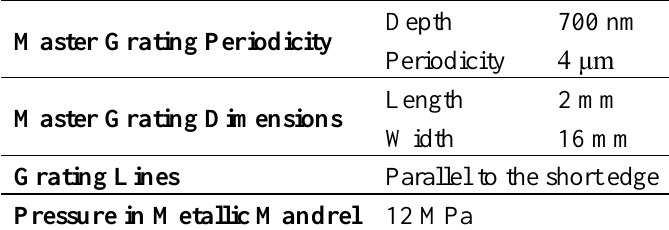
Table 1. Technological data for formation of periodical